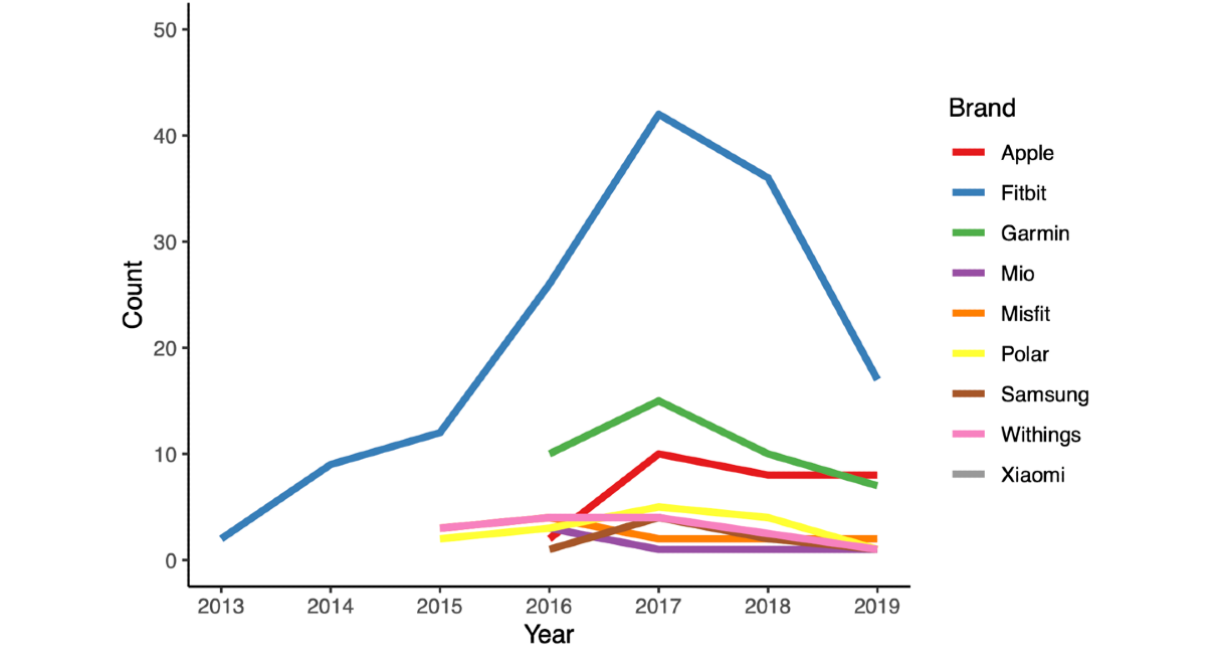
Figure 3. Line graph of studies published per year by device brand.